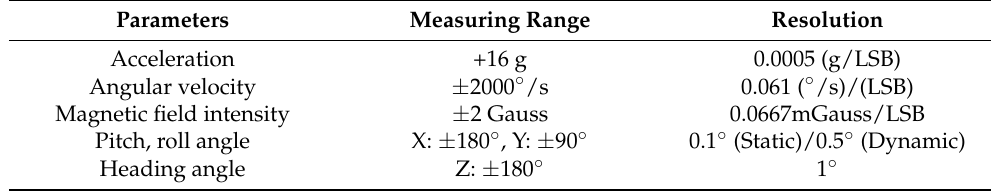
Table 2. The specifications of the JY901s MEMS